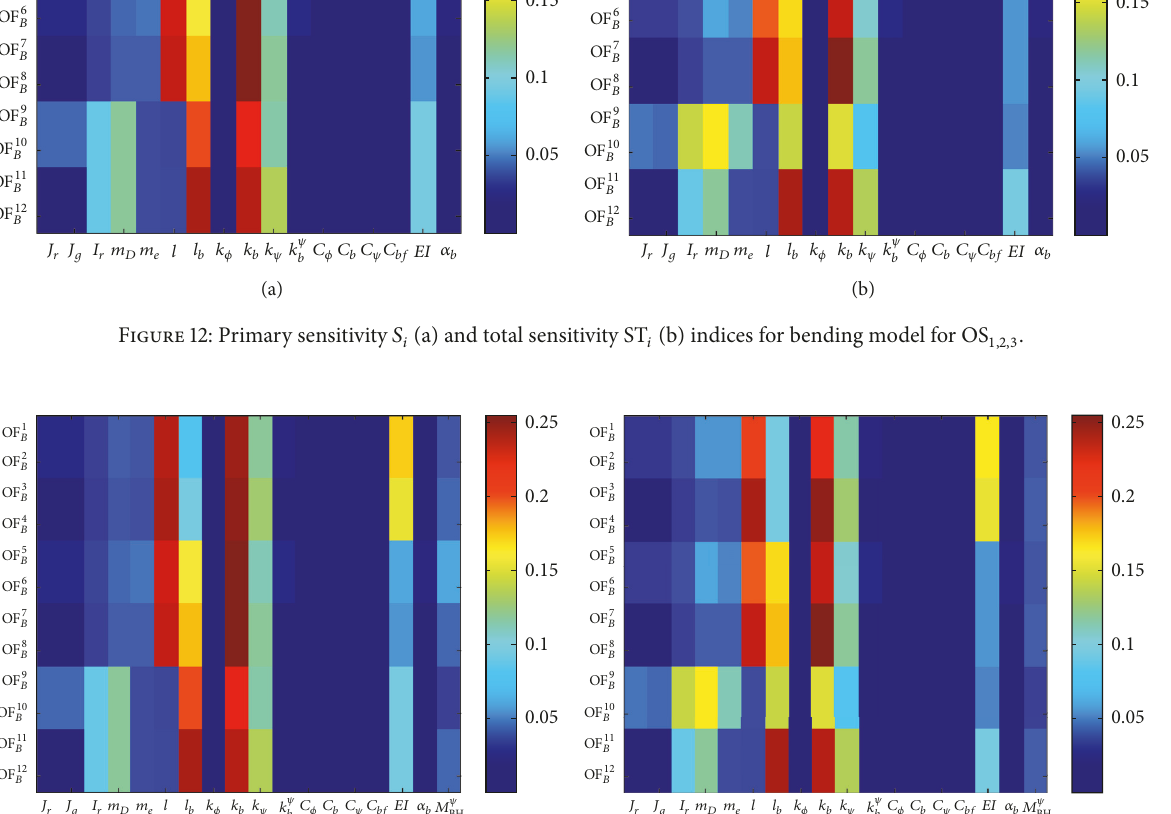
Among the mass inertia parameters, 𝐼 𝑟 , 𝑚 𝑒 , and 𝑚 𝐷 affect most of the bending objective functions.